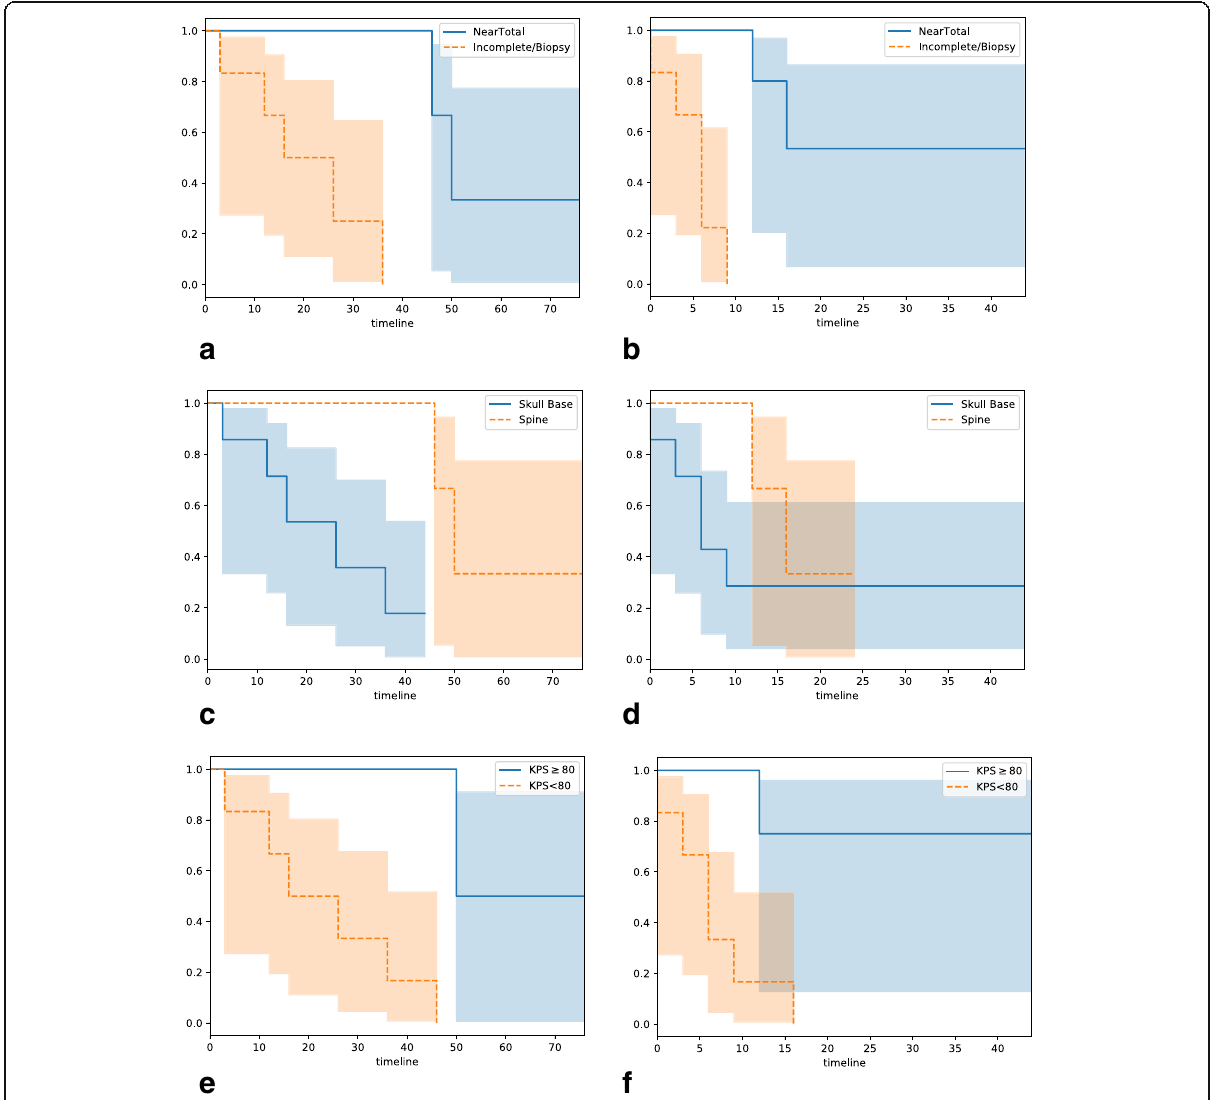
Fig. 4 Survival curves in relation to risk factors ( a ) OS by resection, b PFS by resection, c OS by site, d PFS by site, e OS by pre-op KFS, and f PFS by pre-op